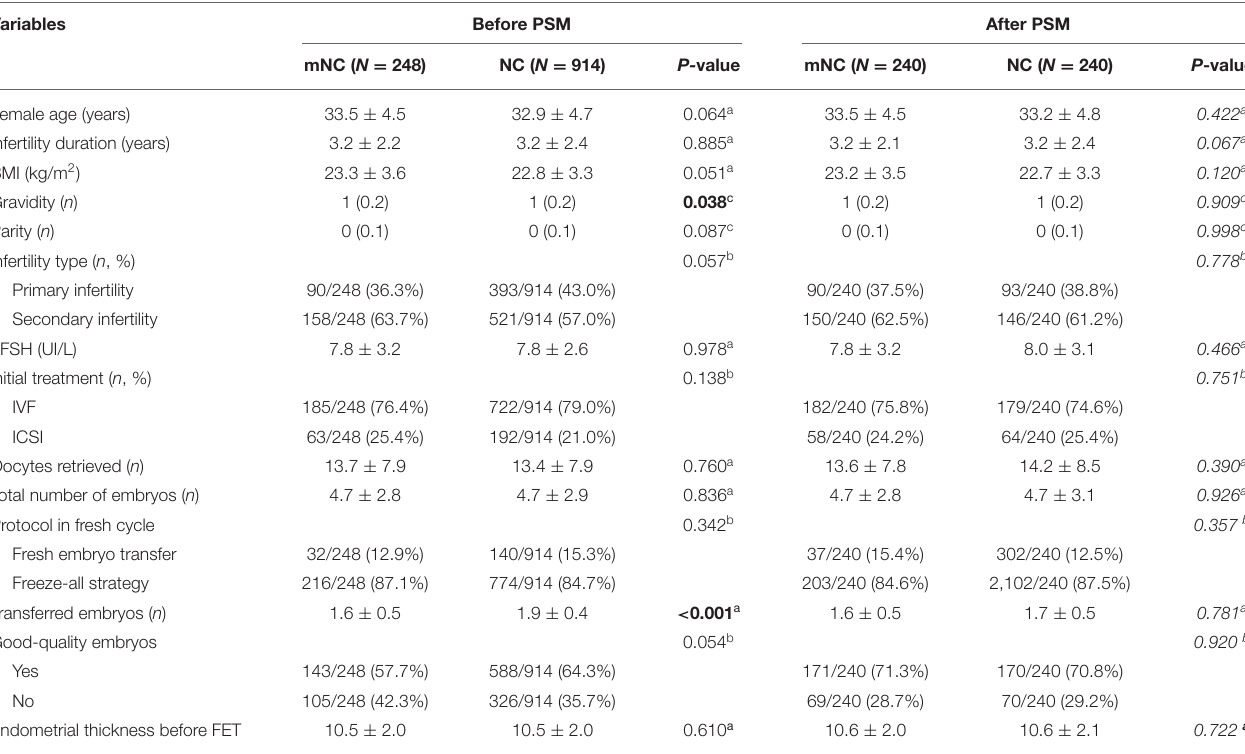
TABLE 1 | Demographic characteristics of two groups before and after PSM.